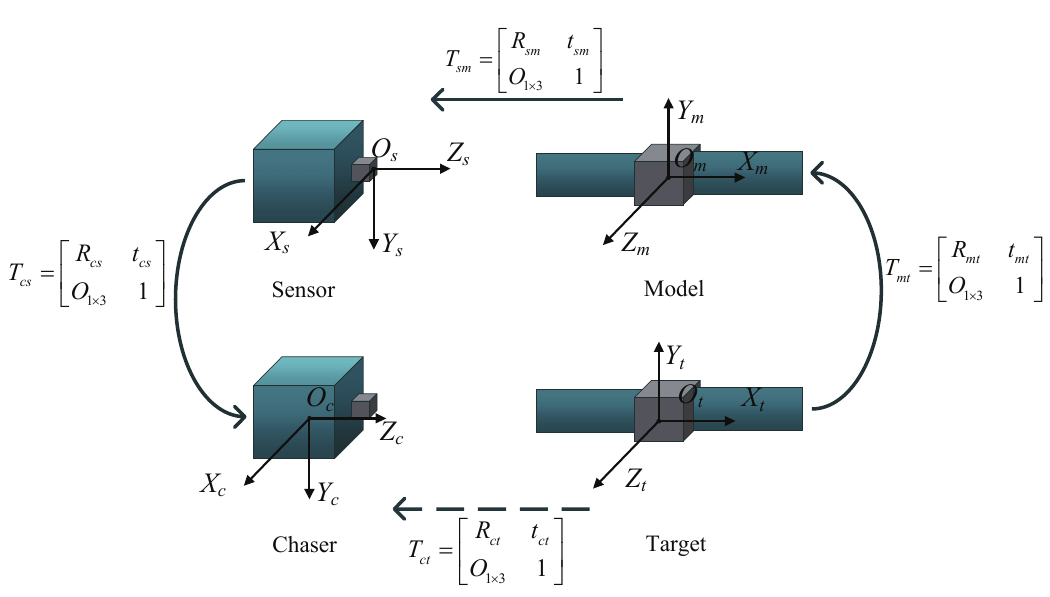
Figure 2. The definition of reference frames